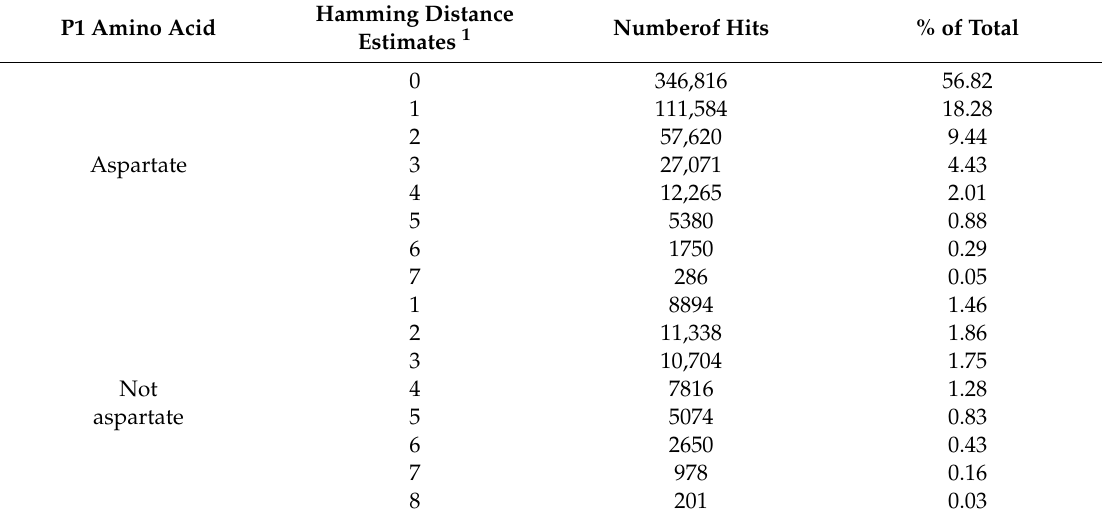
Table 2. Distribution of orthologous caspase targets by cleavage site conservation and presence of aspartate in the P1